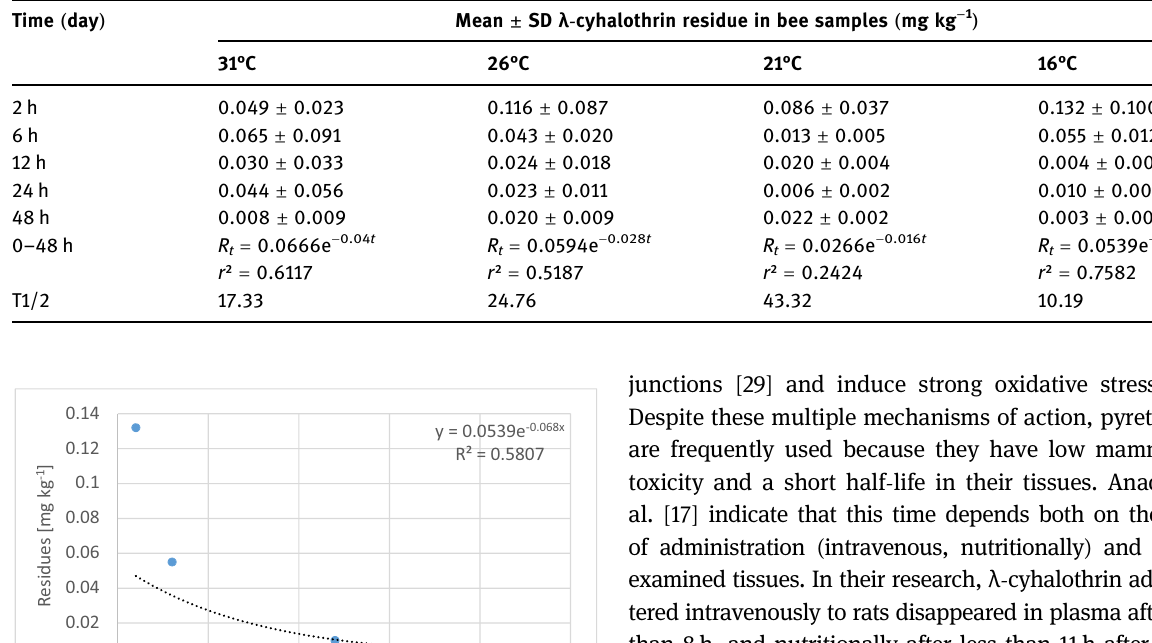
Table 2: Residues ( mg kg 1 ) of λ - cyhalothrin in honey bees, 2, 6, 12, 24, and 48 h after poisoning and the parameters of their exponential degradation